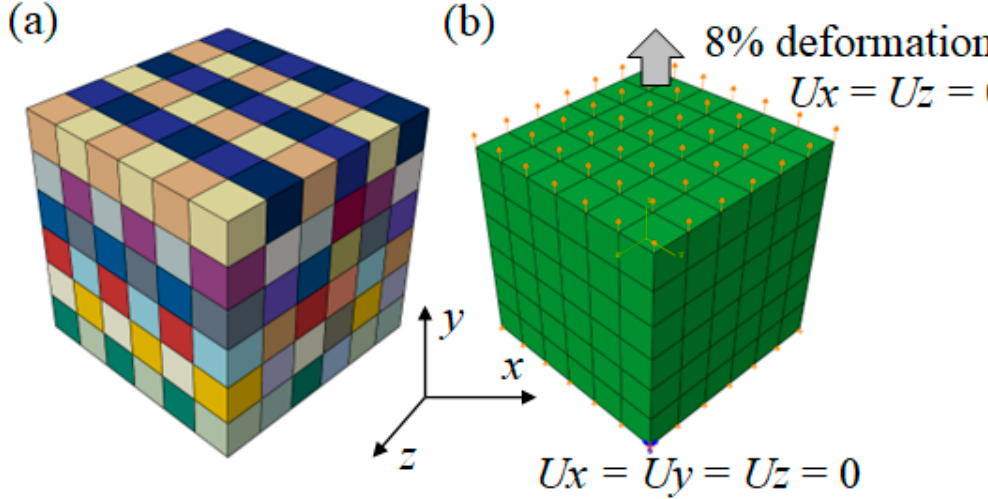
Figure 2. CPFEM model: ( a ) geometric model; ( b ) boundary conditions.